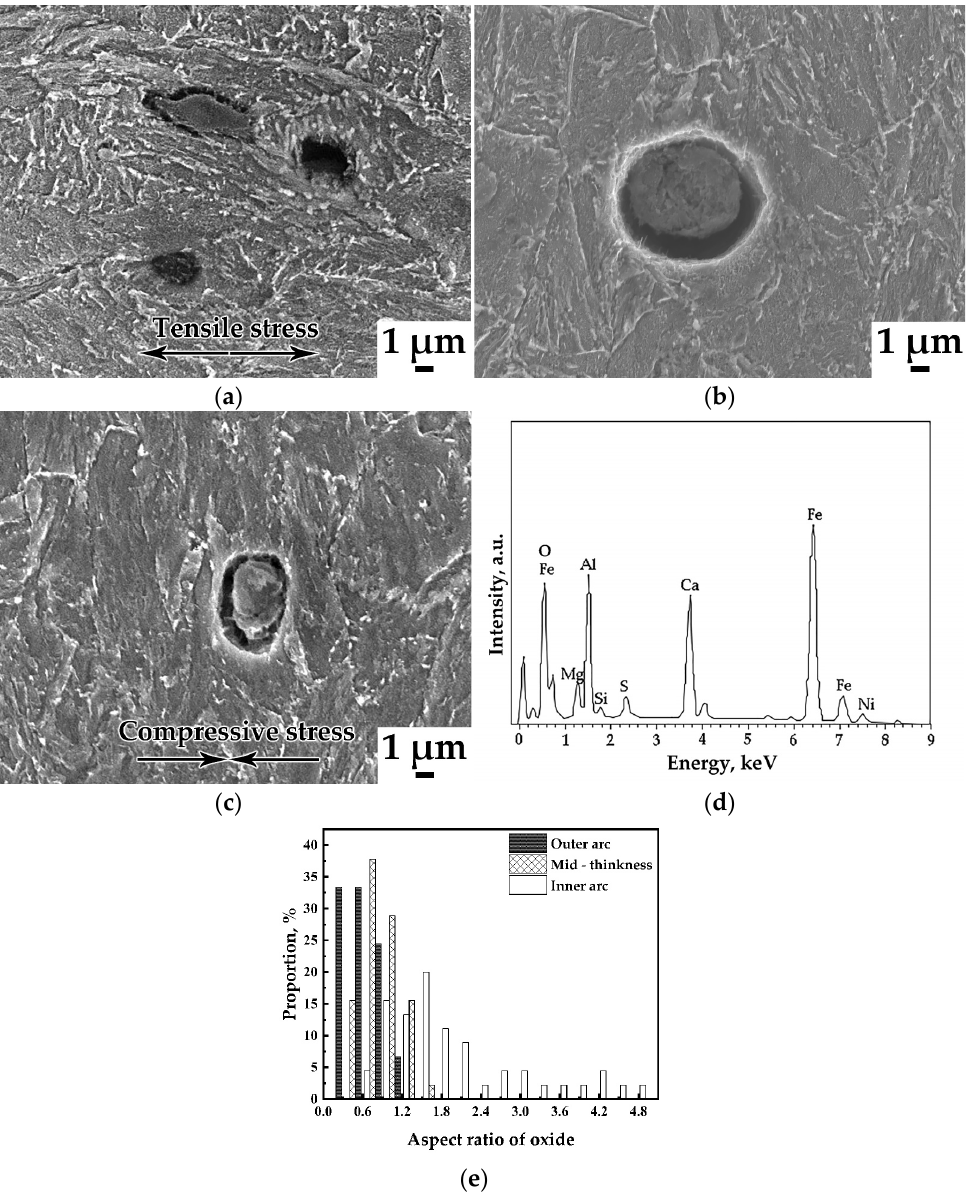
Figure 5. The SEM images at the bending axis near the ( a ) outer arc, ( b ) mid-thickness, and ( c ) inner arc. ( d ) Energy dispersive spectra of the oxide inclusions, and ( e ) aspect radio distribution of oxide inclusions.